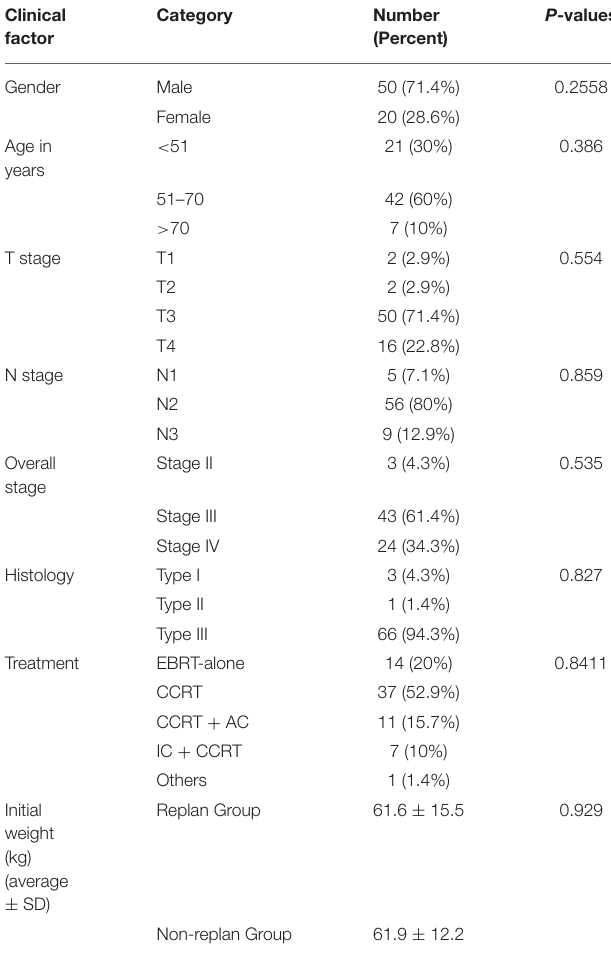
TABLE 1 | Patient characteristics in the present